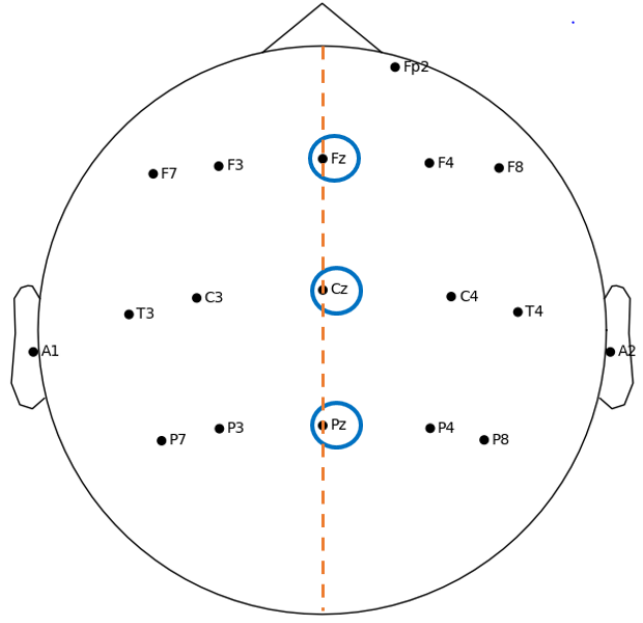
Figure 2. International 10–20 system (channel reduction). EEG activity related to olfactory is recorded with electrodes placed in the midline (orange line) at the Fz, Cz and Pz